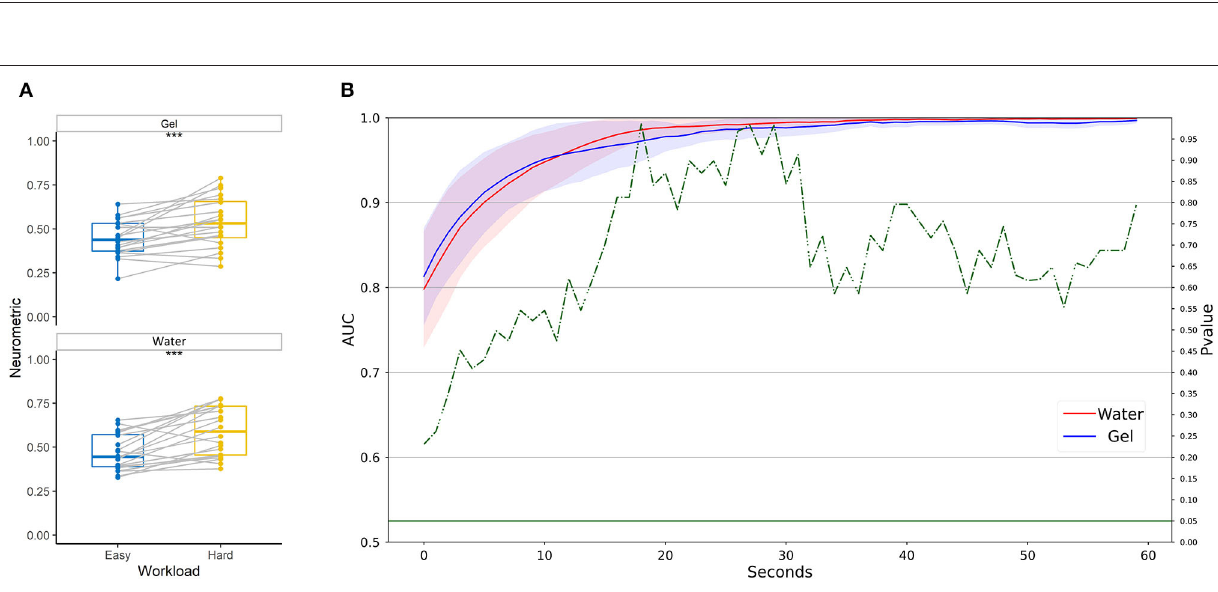
FIGURE 6 | Workload discrimination between easy and hard conditions in laboratory settings. (A) Statistical comparison has been performed for water-based and gel-based Neurometrics. The asterisks show the results of the Wilcoxon signed-rank test (*** p < 0.001). (B) AUC values obtained by water (red) and gel (blue) electrodes for different time resolutions (1–60s). The solid lines represent the median of the AUC among the participants. The shadows represent the mean absolute deviation of the AUC across participants. The dashed green line represents the results in terms of p -values of the Wilcoxon signed-rank test. The threshold of significance ( p = 0.05) has been highlighted in the same